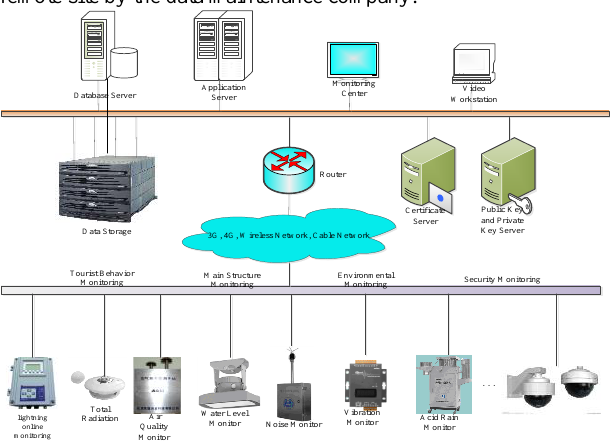
Figure 2. Streamline Chart of the data collection, processing, and release of monitoring system